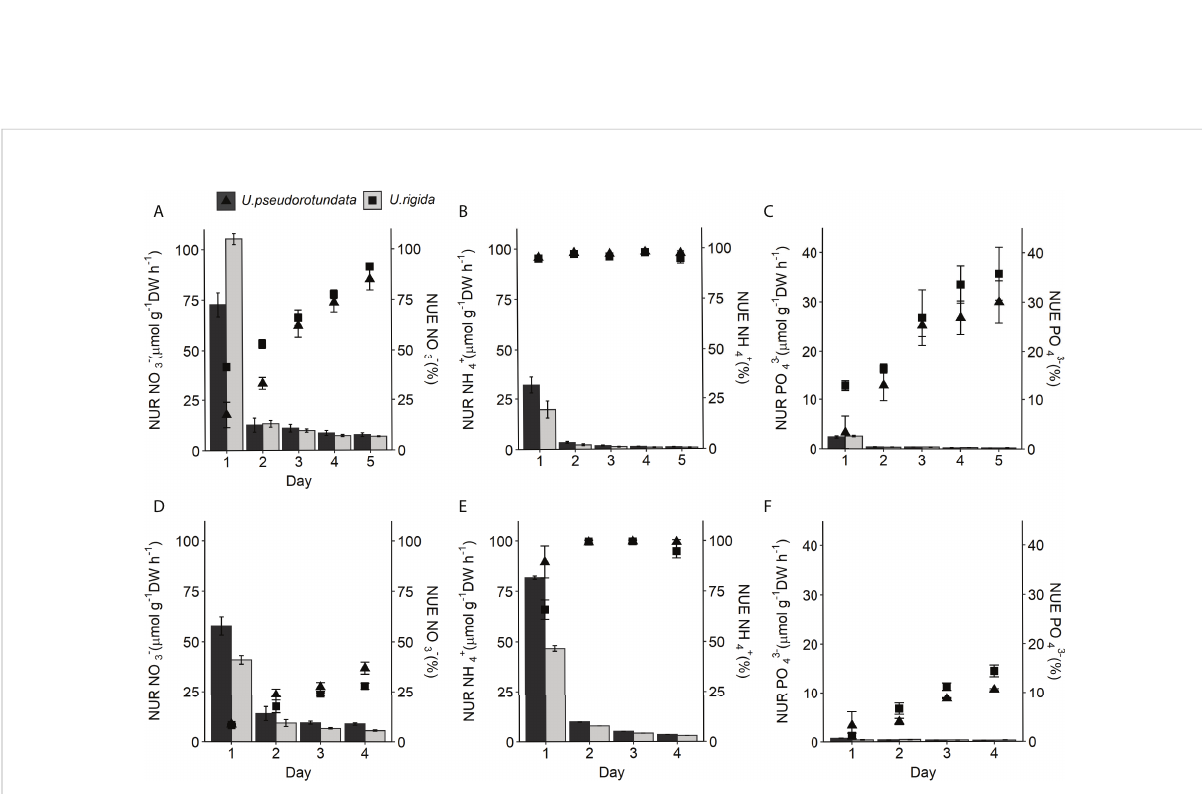
FIGURE 5 NO 3 - , NH 4 + , and PO 4 3- removal rate - NUR (bars) and uptake ef fi ciency - NUE (symbols) by U. pseudorotundata and U. rigida in fi sh ef fl uents. (A – C) refer to experiment 1, conducted during 5 days with 50% fi sh ef fl uent. (D – F) refer to experiment 2, conducted during 4 days with 100% fi sh ef fl uent. Values are mean ± SD, n =